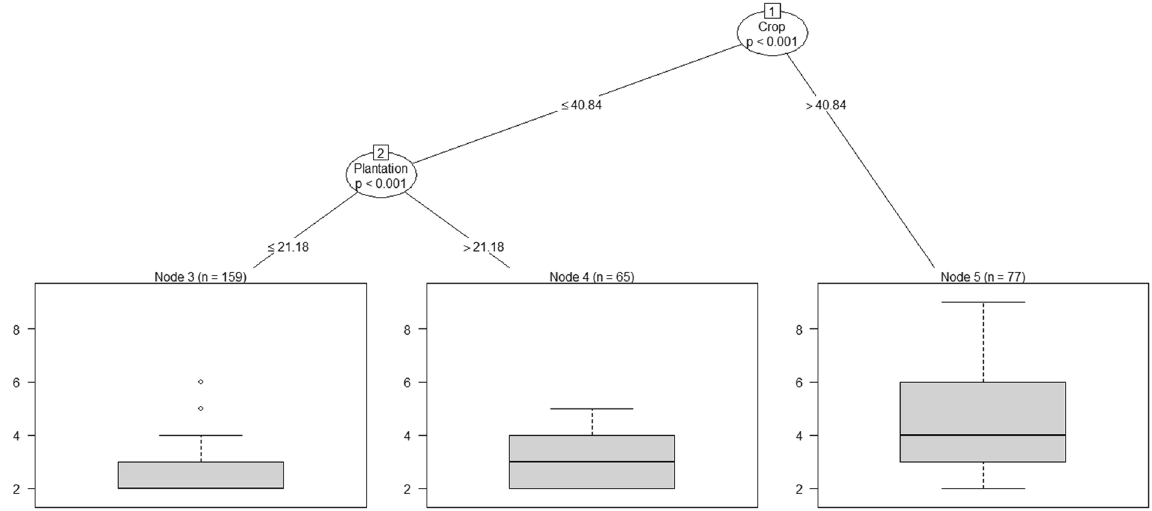
Figure 2. Classification tree showing the relative importance of the different biological and environmental attributes, with statistically significant branches at Nodes, in determining the size of all-male groups of elephants.